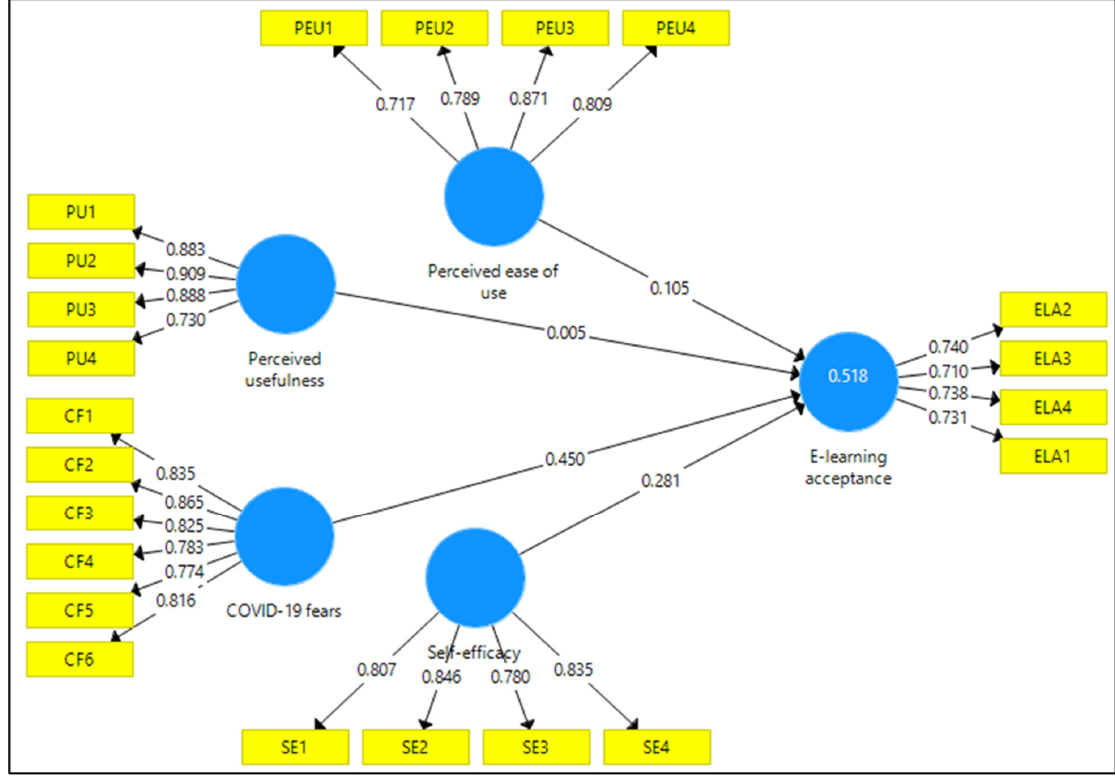
Fig. 2. Path coefficient